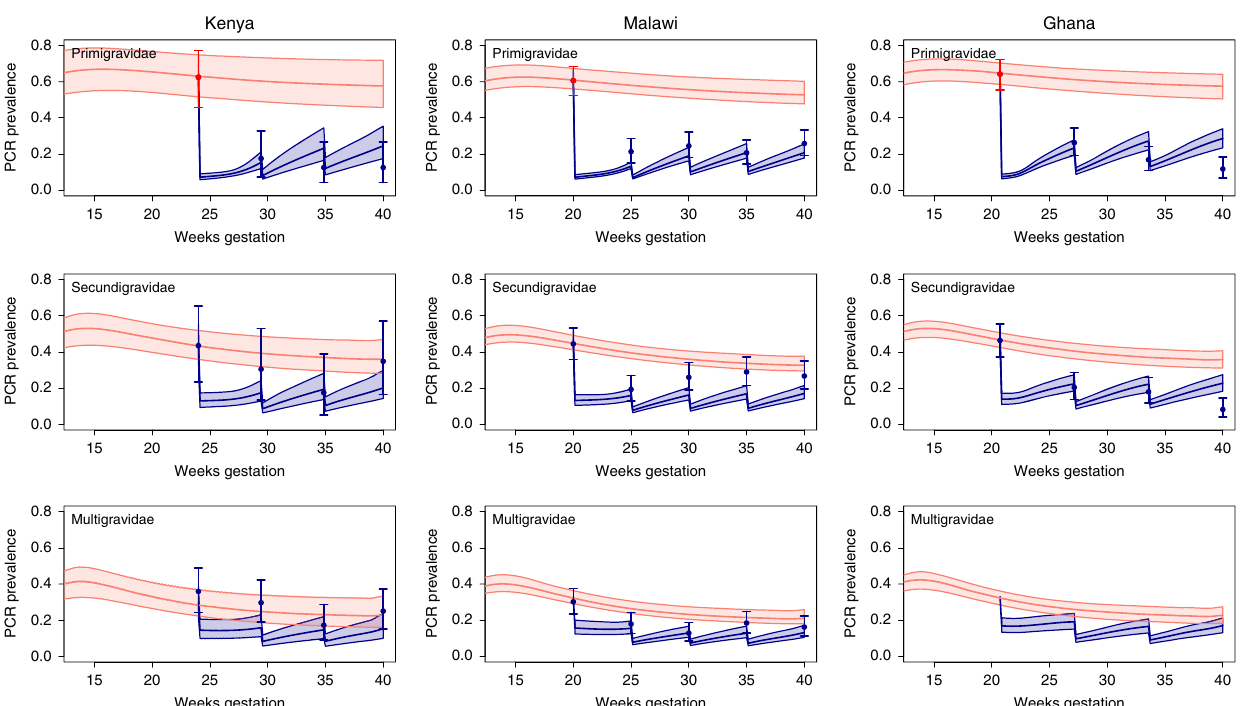
Fig. 3 Comparison of simulated and observed dynamics of infection throughout trials of ISTp. Figure shows observed PCR prevalence throughout successive screens during pregnancy (dots with error bars representing 95% CIs). Pink areas show the 95% CI for PCR prevalence throughout pregnancy in the absence of intervention. Red datapoints indicate observed prevalence at enrolment in primigravidae to which the model is calibrated for each trial, the remaining datapoints, marked in blue, represents dynamics the model aims to replicate, with sharp drops in prevalence corresponding to ISTp rounds. Blue areas show the 95% CIs generated by the posterior distribution of the fi tted model in each scenario (see Supplementary Methods for full details) with blue lines representing the posterior median PCR prevalence. Note for the trial in Ghana only primi- and secundigravidae were recruited but the simulated output is still shown for